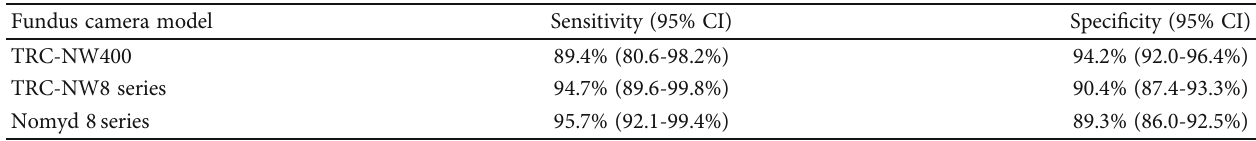
Table 2: Sensitivity and speci fi city of VeriSee DR in diagnosing referable DR in three di ff erent camera models. Fundus camera model